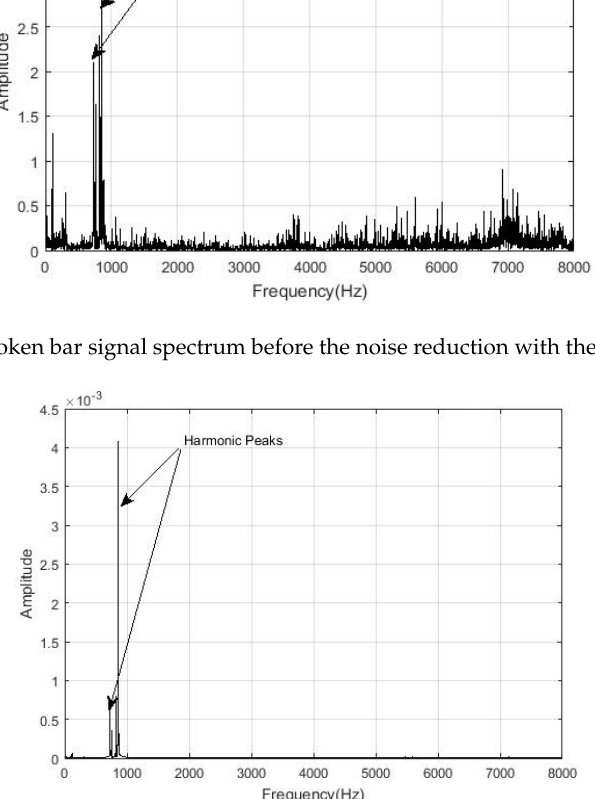
Figure 14. One broken bar signal spectrum after the noise reduction with the harmonic peaks.